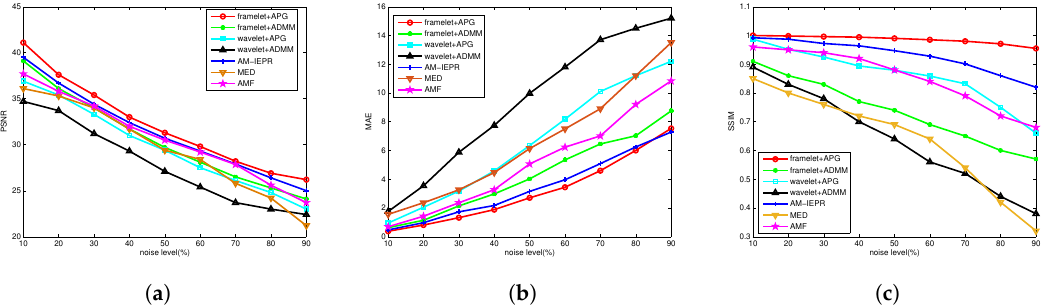
Figure 3. Results of PSNR, MAE, and SSIM at different noise levels. ( a ) PSNR, ( b ) MAE, ( c ) SSIM. PSNR: peak signal-to-noise ratio, MAE: mean absolute error, SSIM: structural similarity